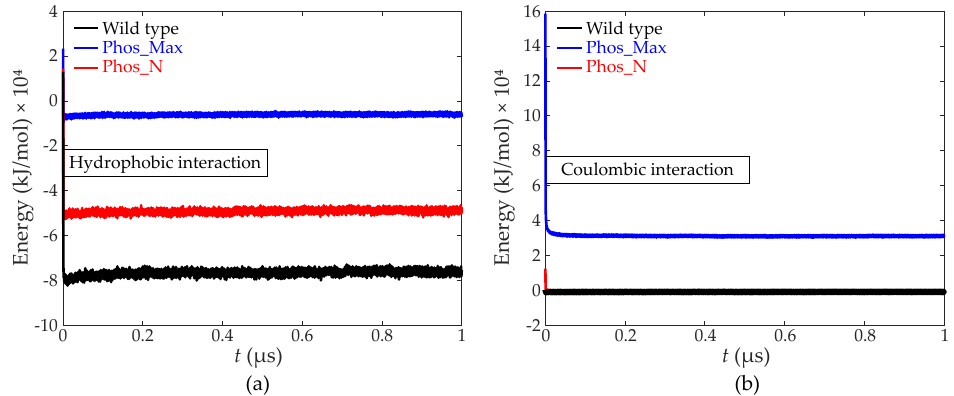
Figure 5. Time evolution of ( a ) the hydrophobic interaction energy, and ( b ) the coulombic interaction energy of the FG-Nups for the wild type (black), Phos_Max (blue), and Phos_N (red)